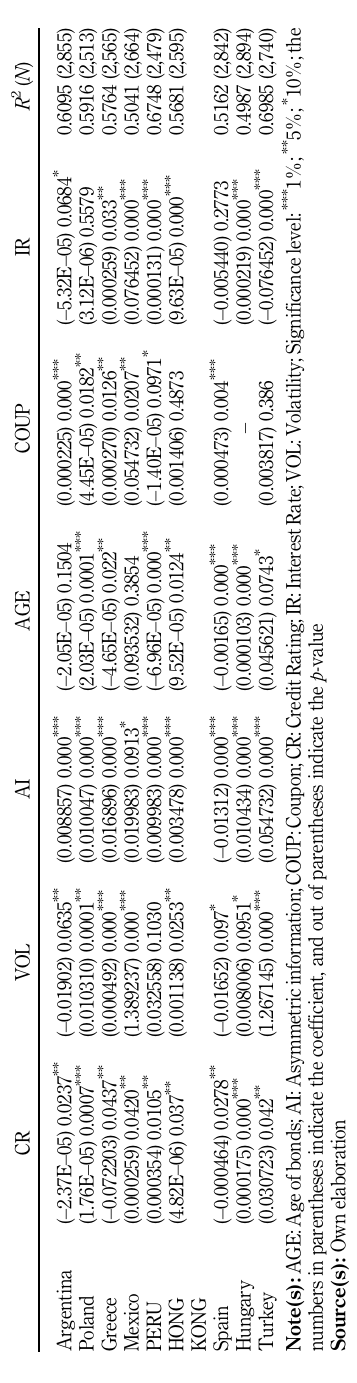
Table 7. Robustness